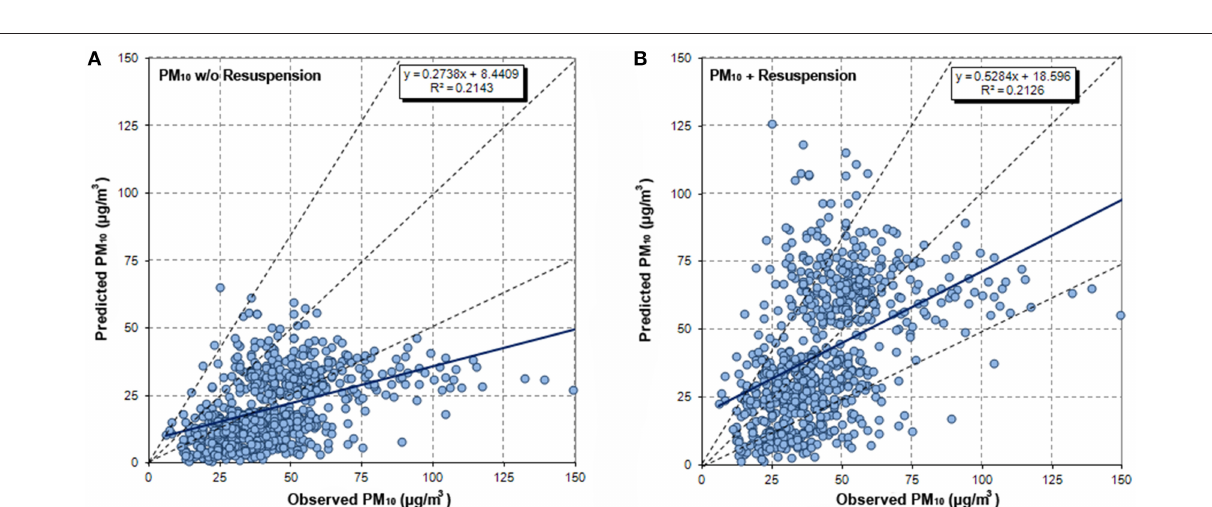
Frontiers in Environmental Science |